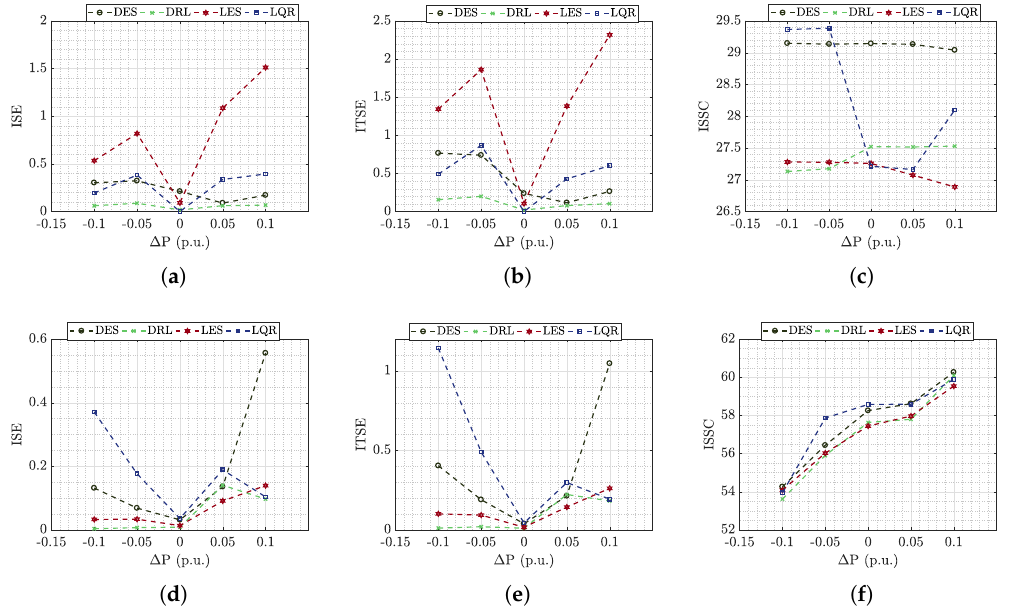
Figure 28. ( a ) ISE, ( b ) ITSE and ( c ) ISSC simulated, ( d ) ISE, ( e ) ITSE and ( f ) ISSC during the test for buck-boost microgrid.